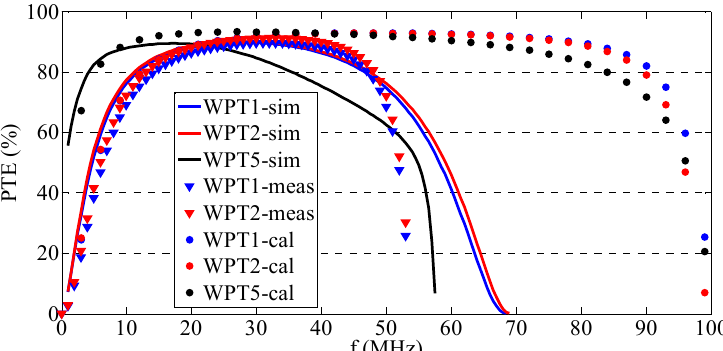
Figure 8. E ff ect of operating frequency on the power transfer e ffi ciency. The terms “-cal”, “-sim”, and Figure 8. Effect of operating frequency on the power transfer efficiency. The terms “-cal,” “-sim,” and “-meas” in the figure refer to the calculation, simulation and measurement “-meas” in the figure refer to the calculation, simulation and measurement results.